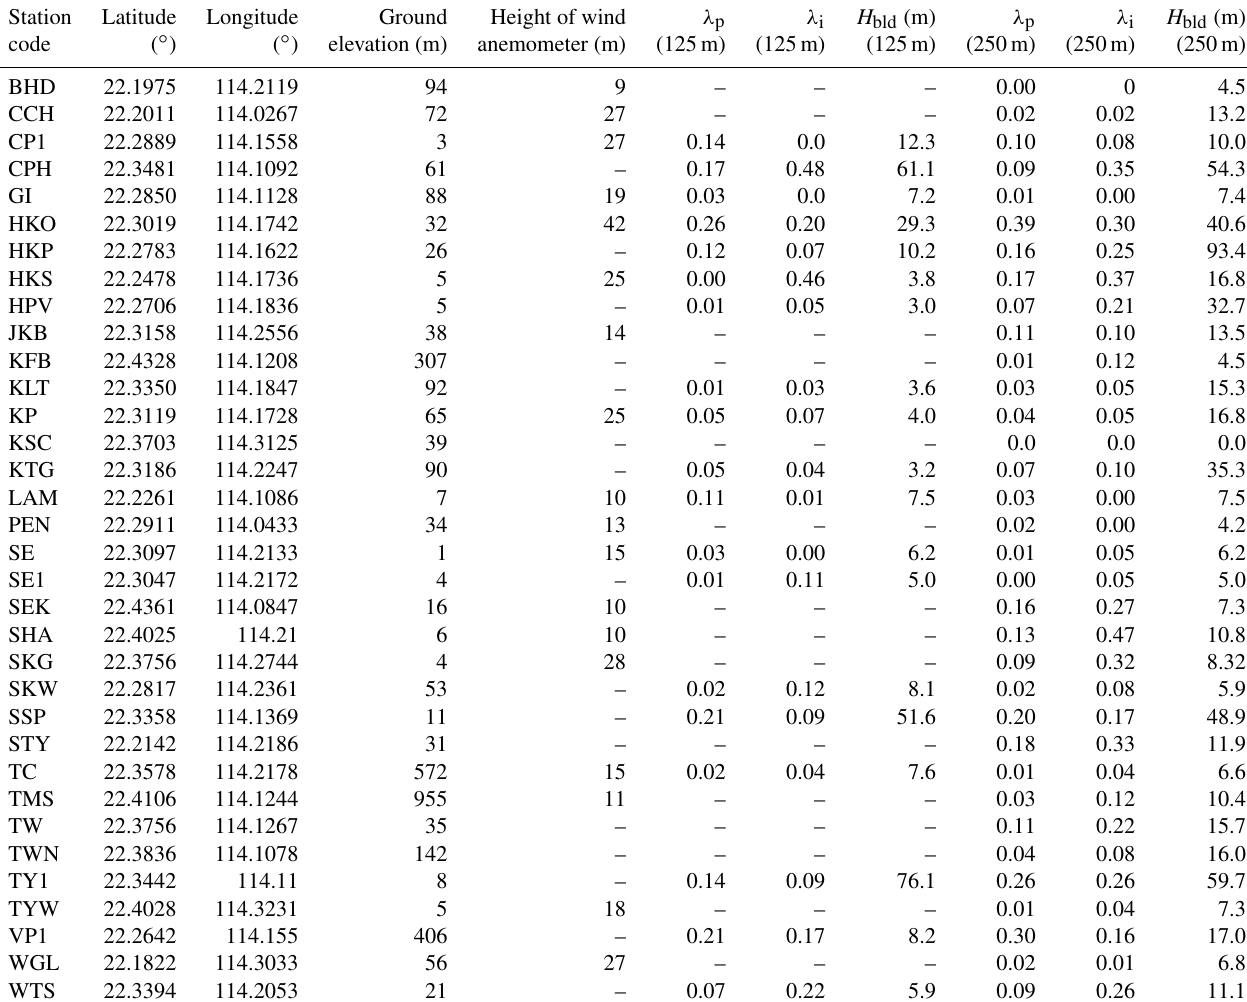
Table A1. Metadata concerning the station network and land cover in their surrounding. λ p and λ i denote the plan area building and imper- vious fraction, respectively. The height a.g.l. of the Stevenson screen is about 1m, except for the CPH station for which it is 62m.